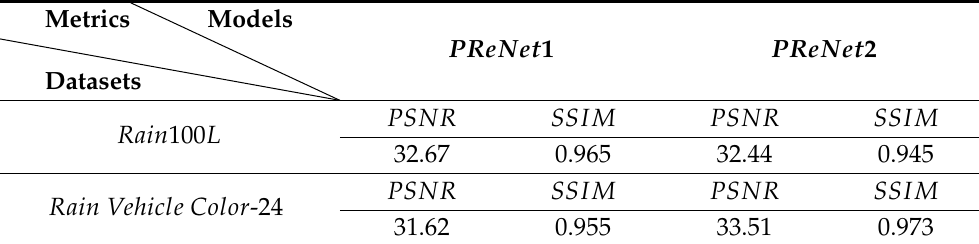
Table 1. Comparing PSNR , SSIM of the PReNet 1 and the PReNet 2 on Rain 100 L , Rain Vehicle Color - 24, respectively.